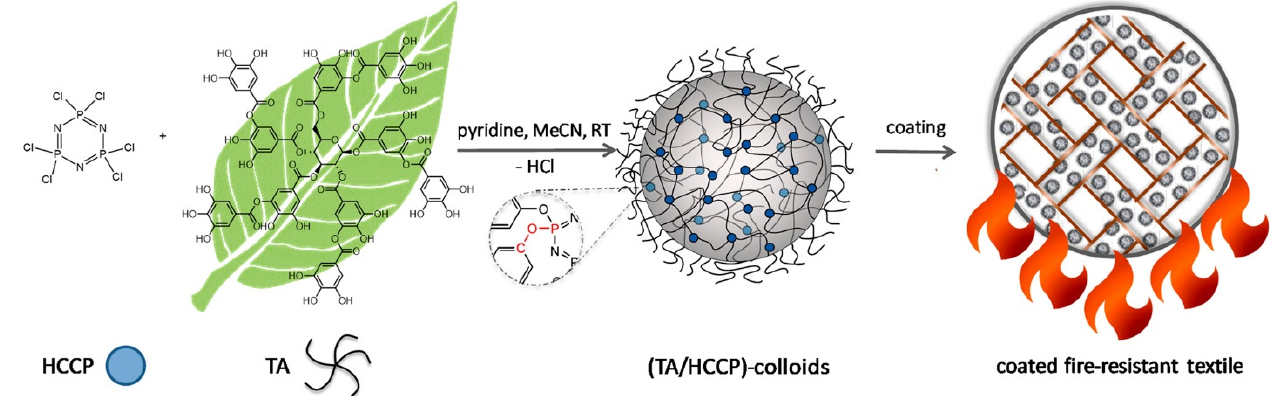
Figure 2. Synthesis route to bio-based (TA/HCCP) colloidal particles through the chemical coupling of hexachlorocyclophosphazene (HCCP) and tannic acid (TA) and the formation of a uniform flame- retardant coating on the textile surface. Reprinted with permission from Ref. [52] Copyright 2020 American Chemical Society.